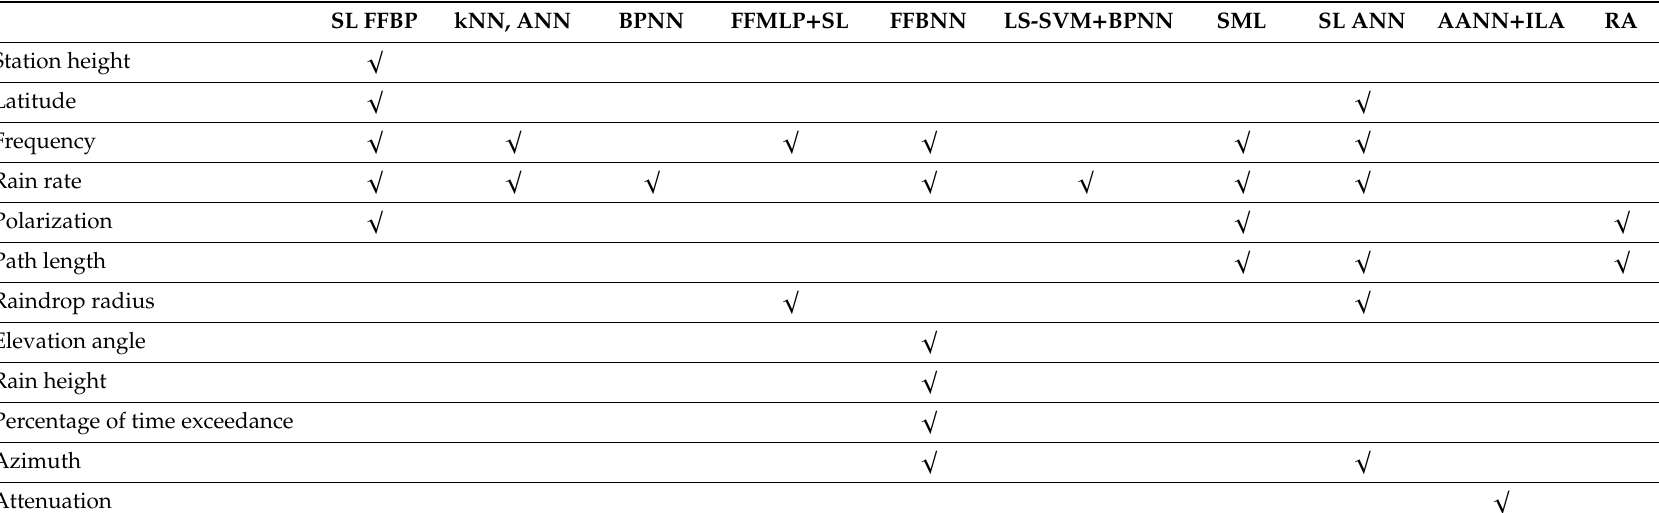
Table 2. The LARA model’s input